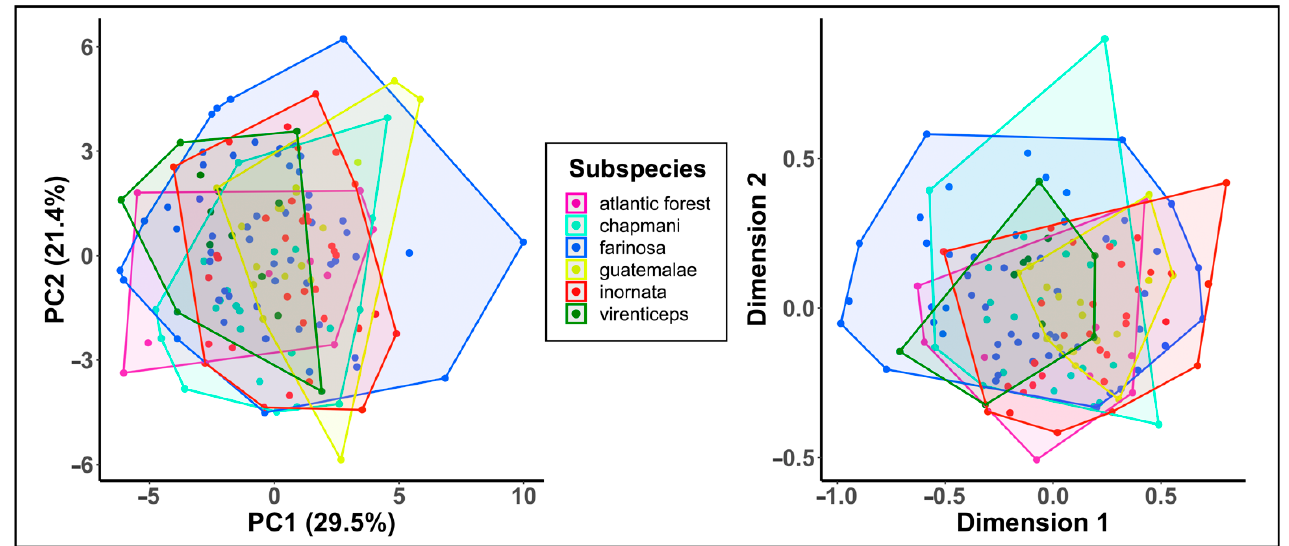
Figure 4. Acoustic variation in call data. Plots of acoustic variation in contact calls based on principle components analysis of 27 call measures ( left ) and a multidimensional scaling of spectrogram cross-correlation values ( right ). The points represent individual calls, and the polygons represent the total area of occupied by each clade’s set of calls in acoustic space.